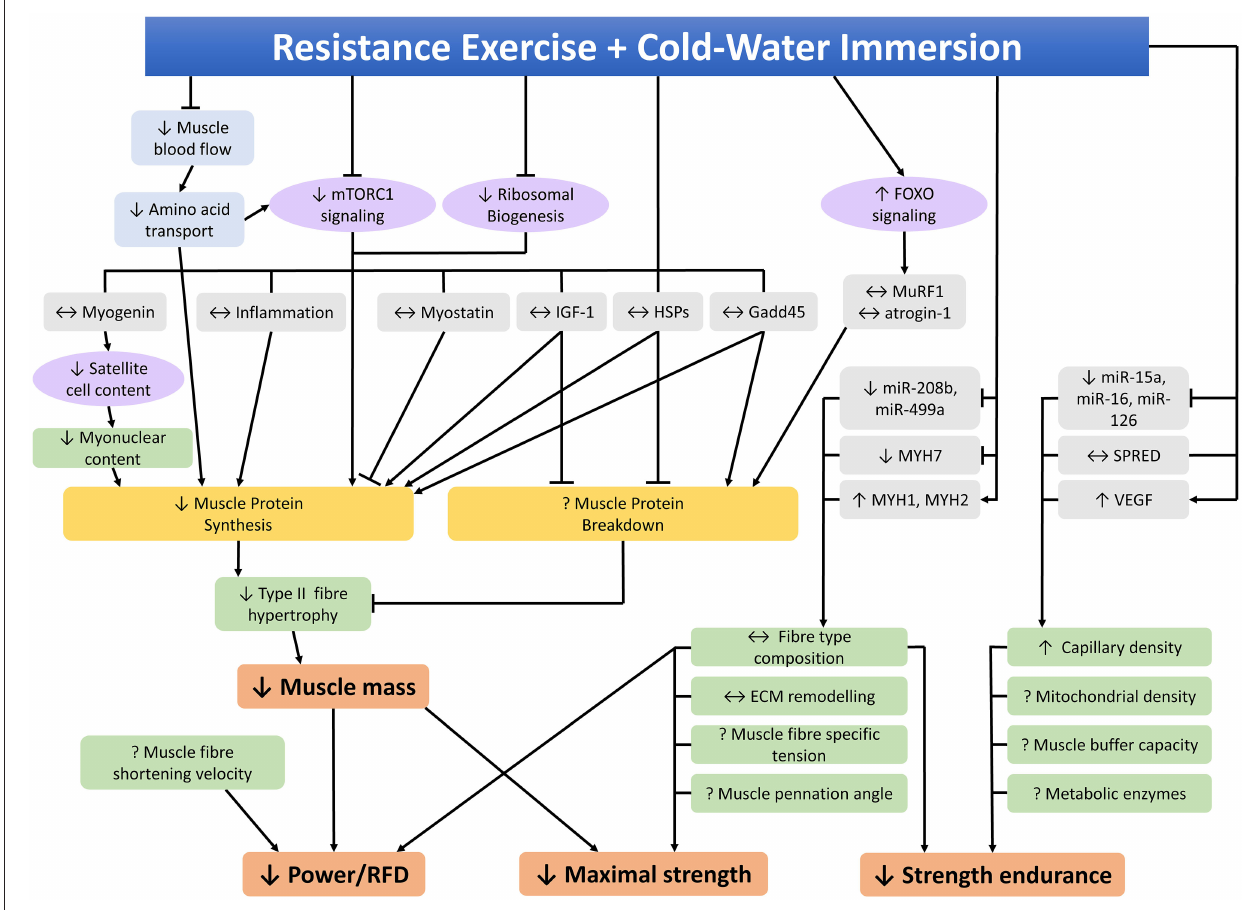
FIGURE 4 | Molecular mechanisms within skeletal muscle that may contribute to the effects of post-exercise cold-water immersion on adaptations to resistance training. ↑ , ↓ , ↔ indicates increased, decreased, or unchanged response compared to the control condition, ? indicates that the effects of cold-water immersion on this variable have not been investigated, RFD rate of force